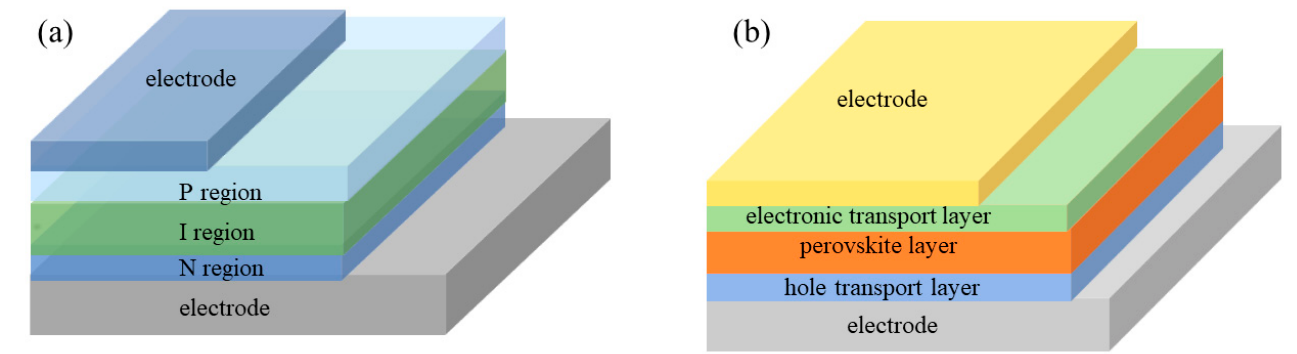
Figure 4. Structure diagram of ( a ) the p-i-n type photodiode and ( b ) the p-i-n type perovskite pho- todiode.